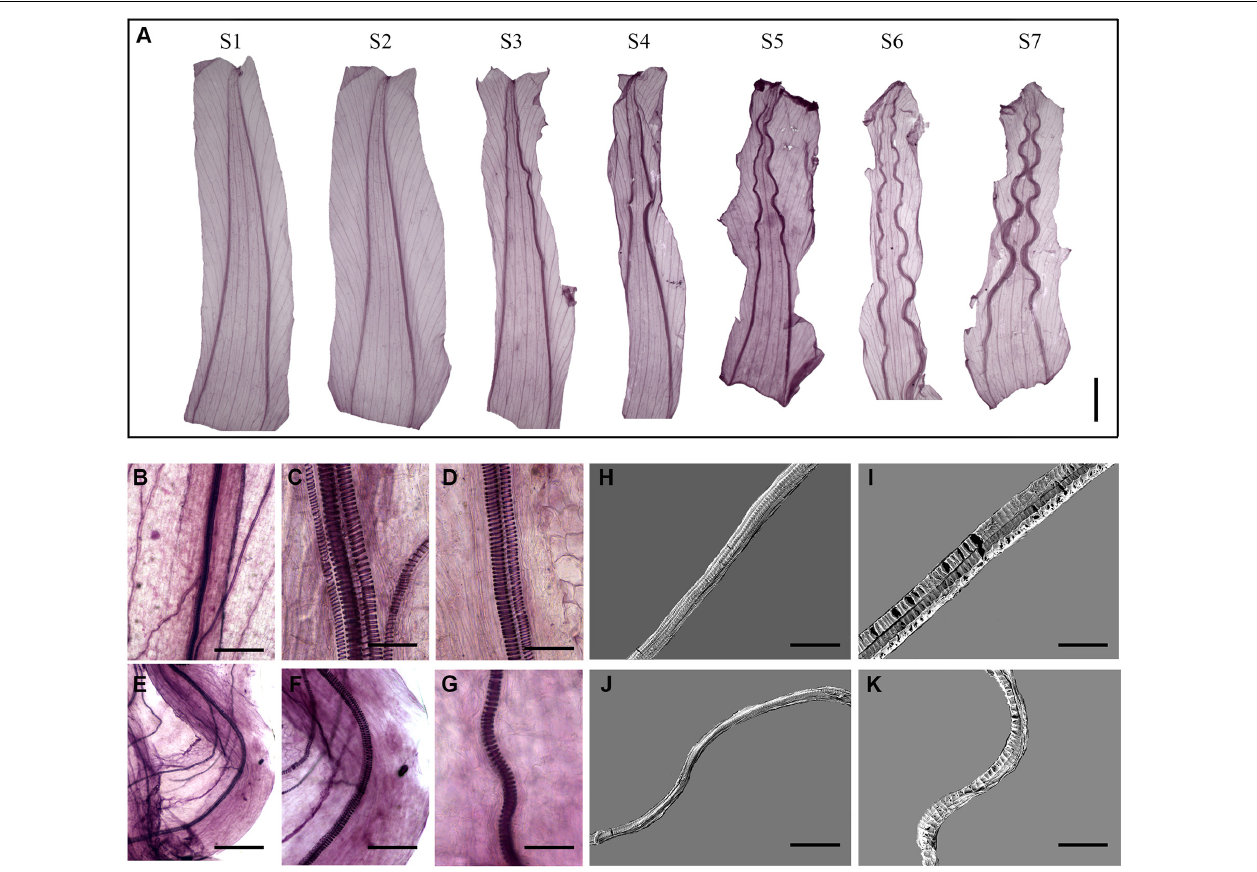
FIGURE 3 | Corolla closure is accompanied by dynamic changes in acuminate vein structure. (A) Tissue transparency showing changes in corolla veins at different stages of closure. Scale bar = 0.5 cm. (B–K) Segregation of spiral vessels observed by light (B–G) and scanning electron microscopy (H–K) . The changes in the vessels at S1 and S7 are shown in (B–D,H,I) and (E–G,J,K) , respectively. Scale bars = 200 µ m in (B,E) , 40 µ m in (C,D,F,G) , 50 µ m in (H,J) , and 30 µ m in (I,K)